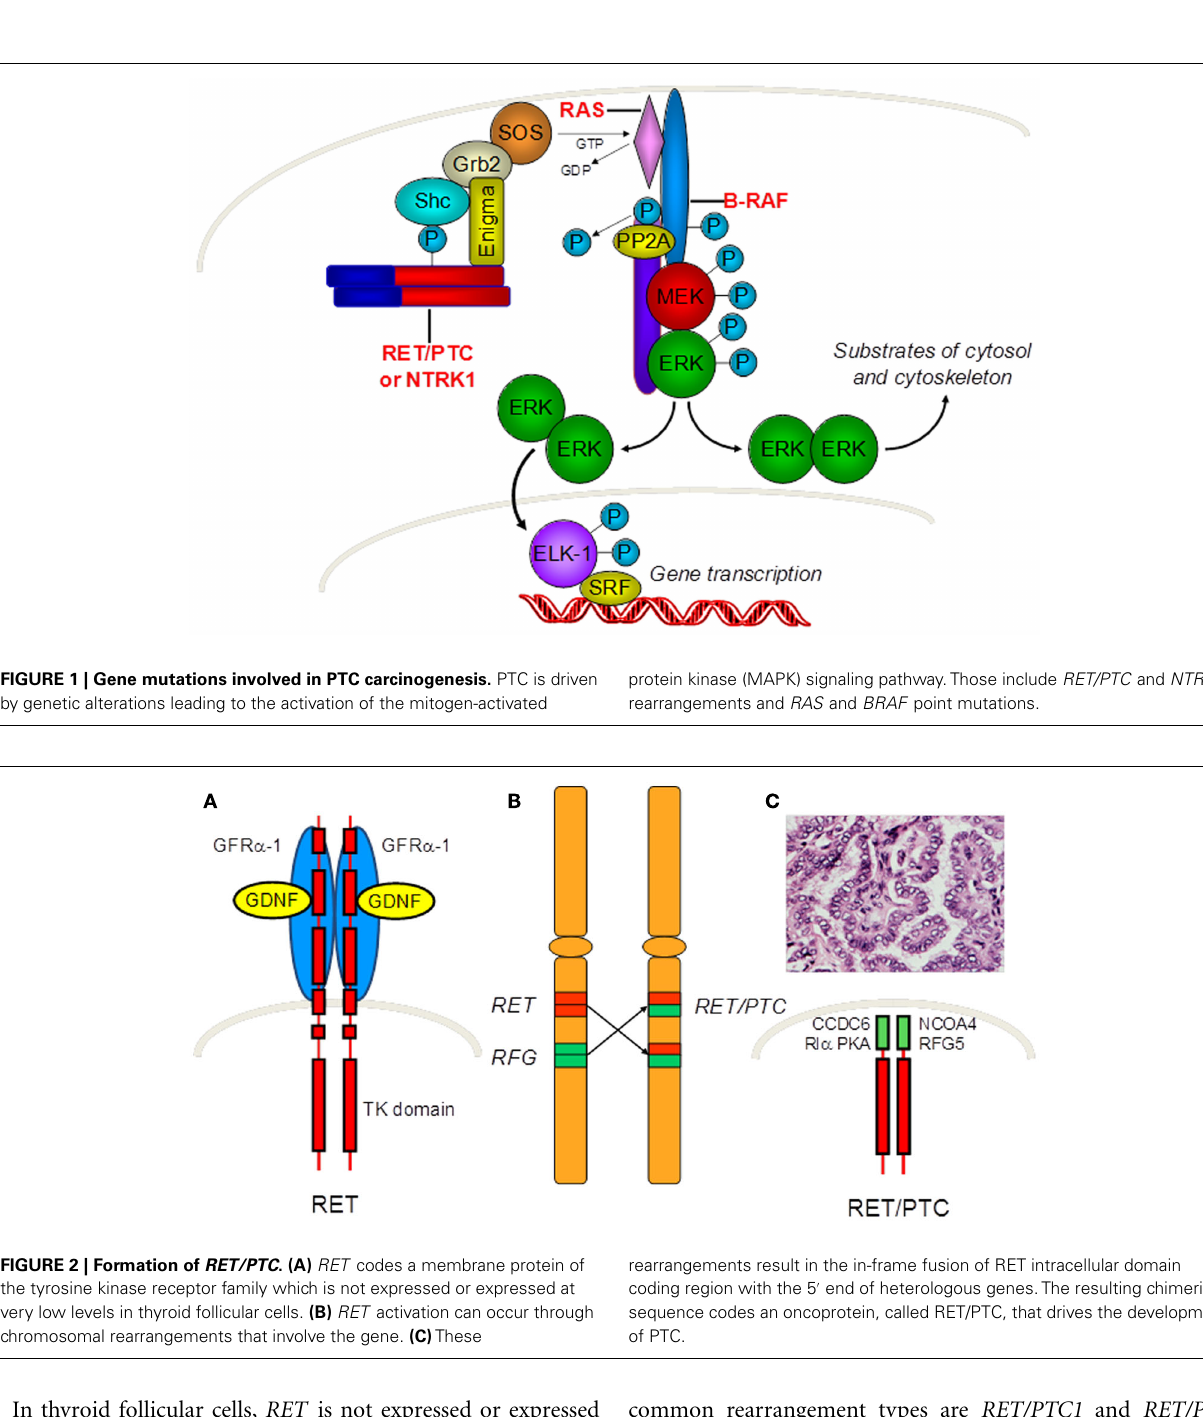
FIGURE 2 | Formation of RET/PTC . (A) RET codes a membrane protein of the tyrosine kinase receptor family which is not expressed or expressed at very low levels in thyroid follicular cells. (B) RET activation can occur through chromosomal rearrangements that involve the gene. (C) These